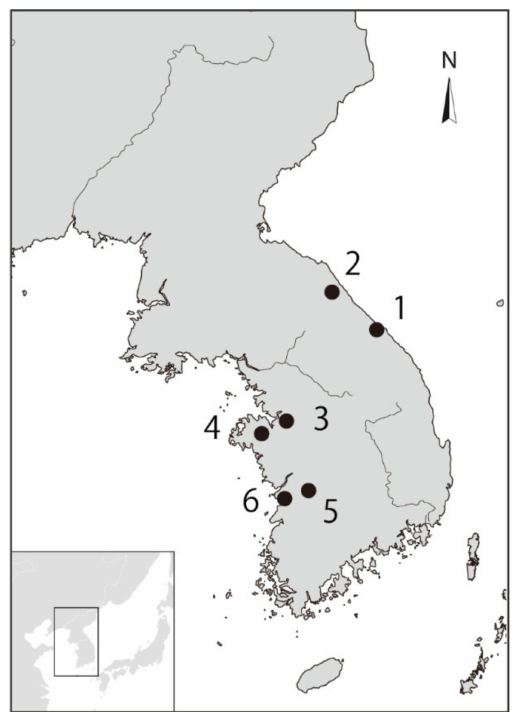
Figure A1. Locations of the archaeological sites investigated in this paper (1: Gyo-dong, 2: Sacheon-ri, 3: Baekseok-dong, 4: Jagae-ri, 5: Yougheung-ri, 6: